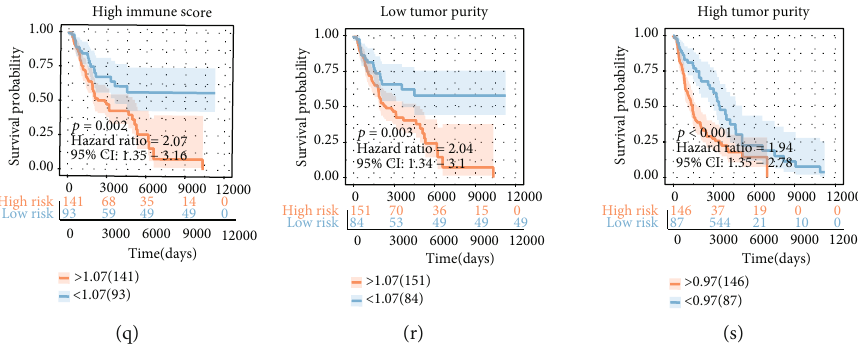
Figure 4: Survival analysis and subgroup analysis. (a – d) Independent prognostic analysis of four factors. (e – s) A subgroup assessment of the prognostic risk score model for M2 macrophage-associated coexpression factors.